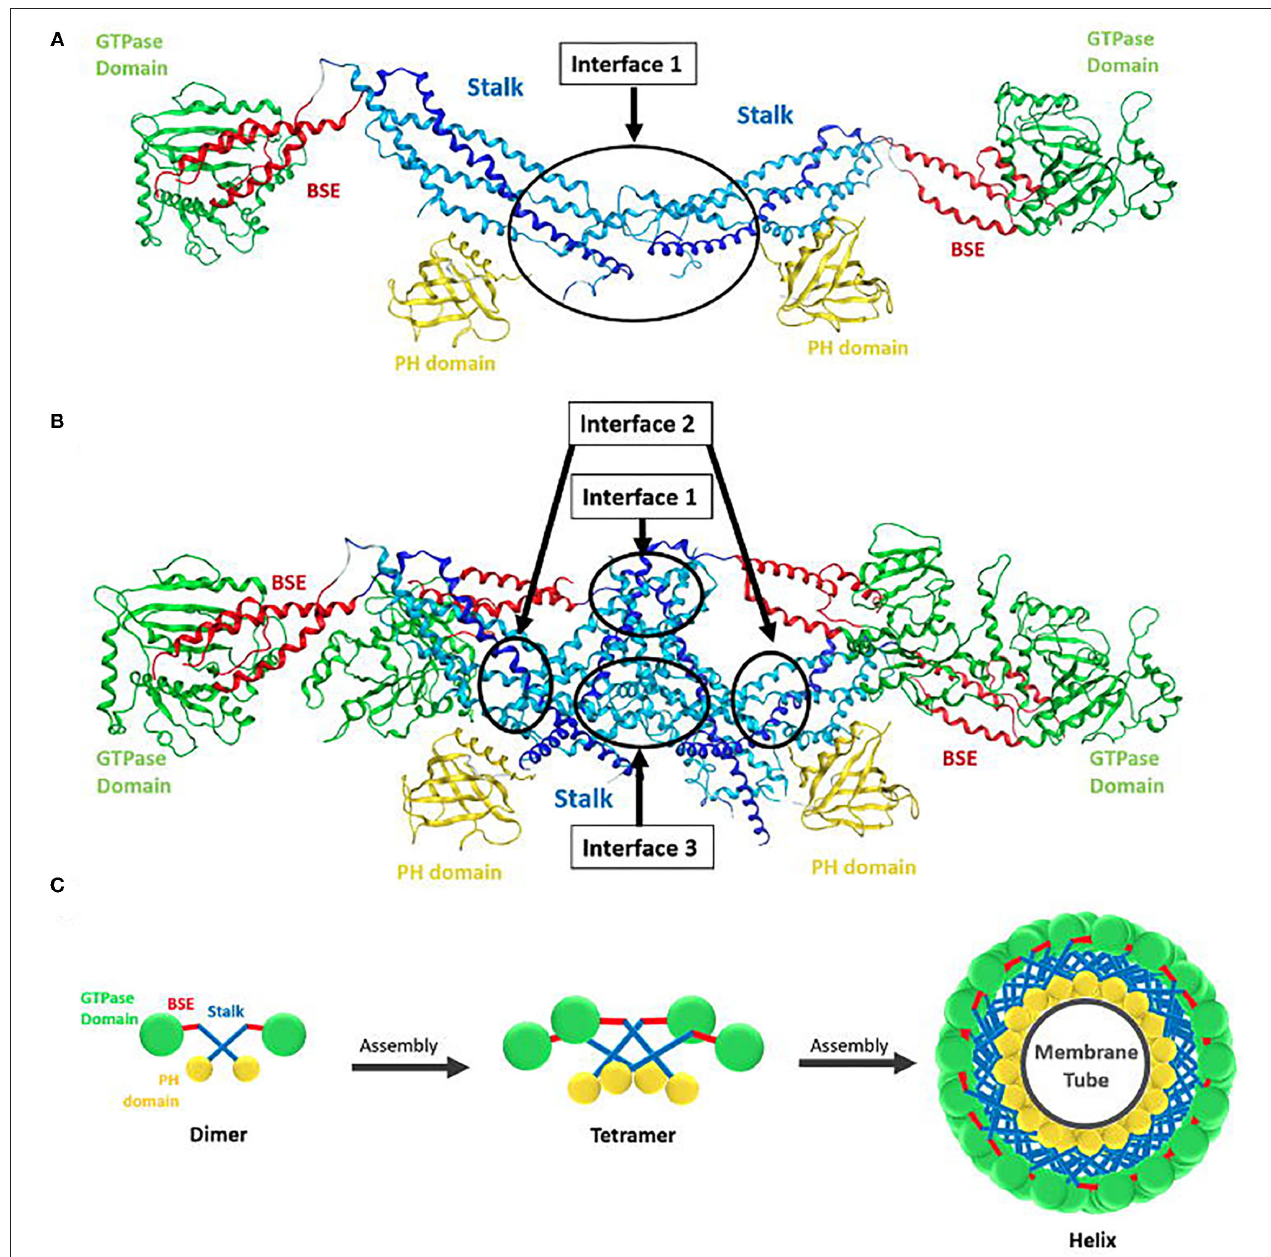
FIGURE 3 | Structure of dynamin dimer and tetramer. (A) Crystal structure of a dimer showing the stalk interface (interface 1) needed for self-assembly (Reubold et al., 2015). (B) Crystal structure of a tetramer showing the stalk interfaces (interfaces 1, 2, and 3) needed for self-assembly. GTPase domain (green), BSE (red), stalk region consists of the middle domain (light blue) and GED (dark blue) and the PH domain (yellow) (Reubold et al., 2015). (C) Structure of dynamin and its assembly into oligomers. Ball and stick representation of a dynamin dimer and tetramer, showing how the dimer polymerize into a tetramer and how tetramers further assemble into a helix around a membrane tube. The GTPase domain is represented in green, BSE in red, stalk in blue, and PH domain in yellow (Chen et al., 2020).